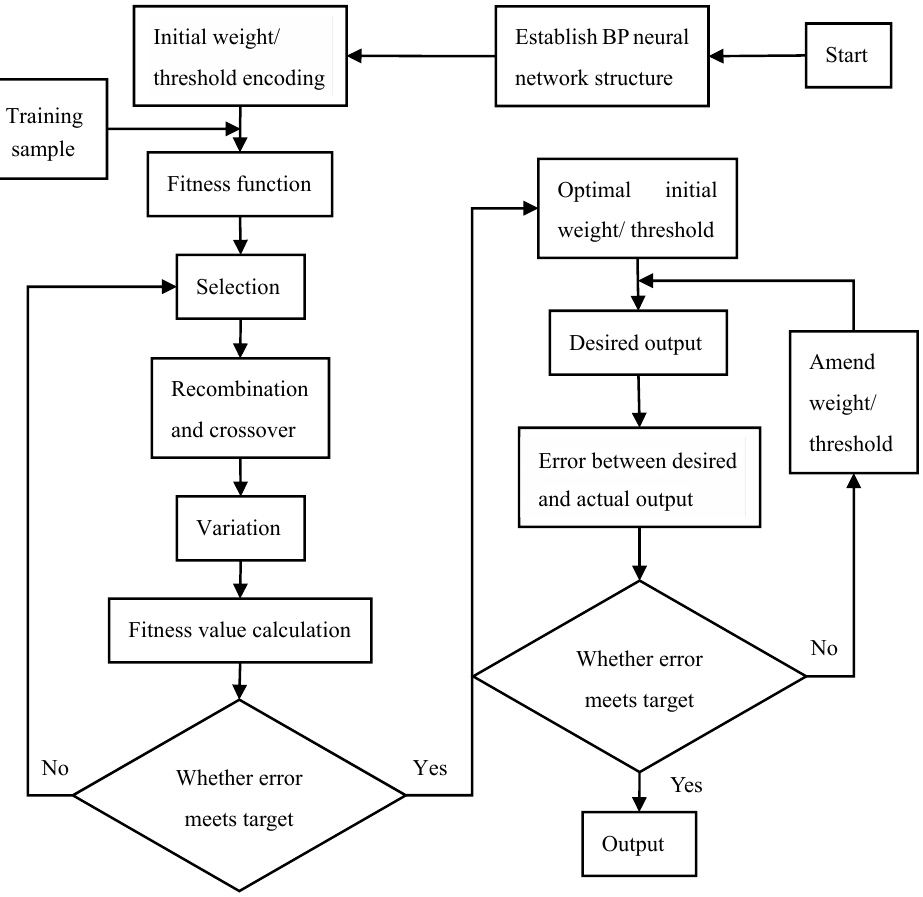
Figure 6. Flow chart of BP network optimized by genetic algorithm.